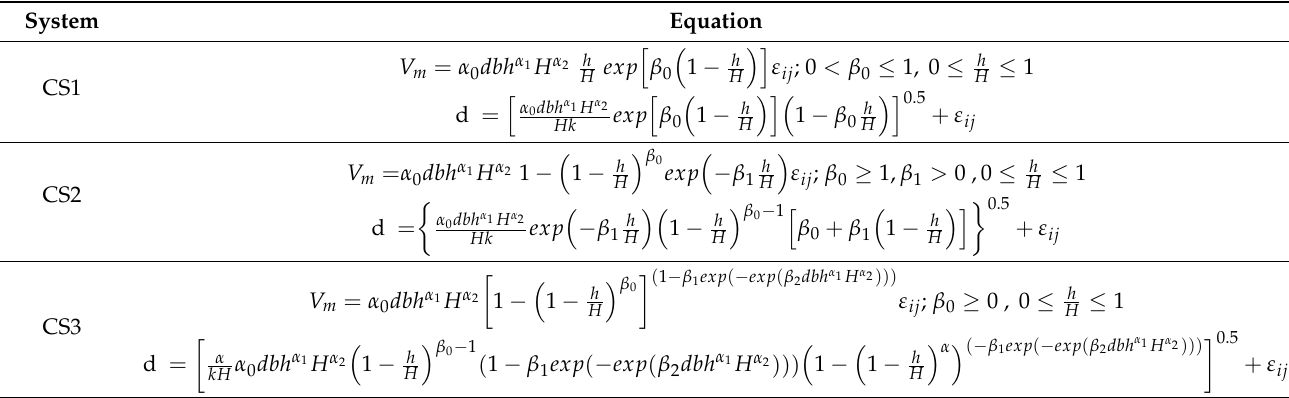
Table 2. Compatible taper and merchantable volume systems based on volume ratio models fitted to studied species.